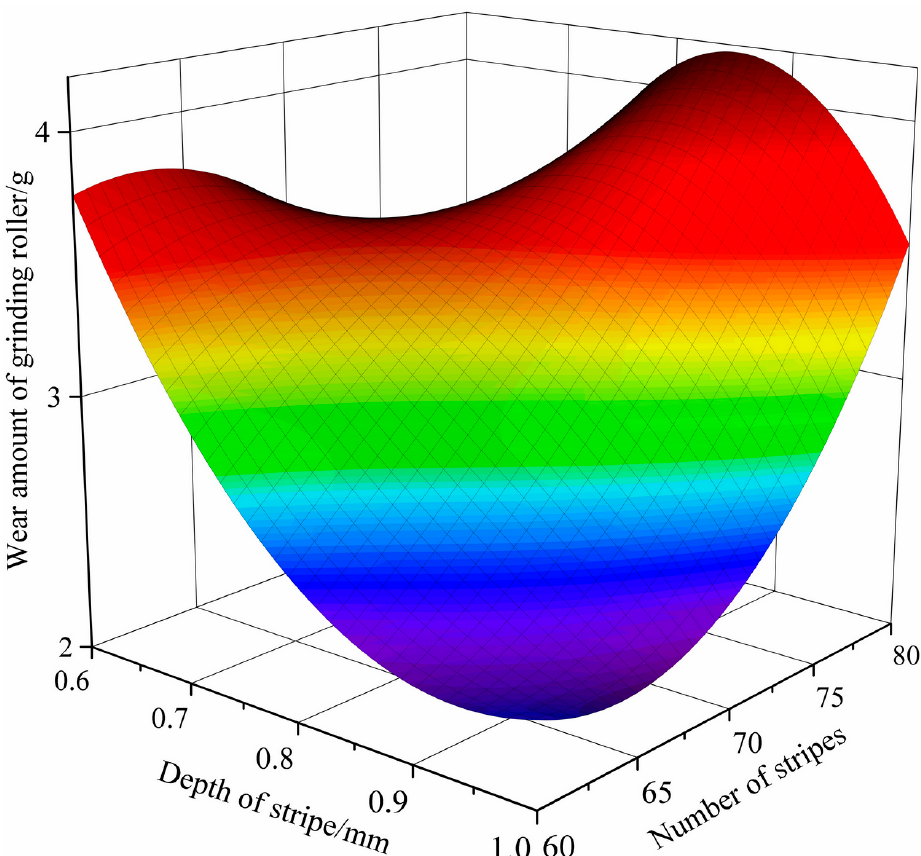
Figure 5. Effect of stripe depth and the number of stripes on wear performance of grinding rollers.